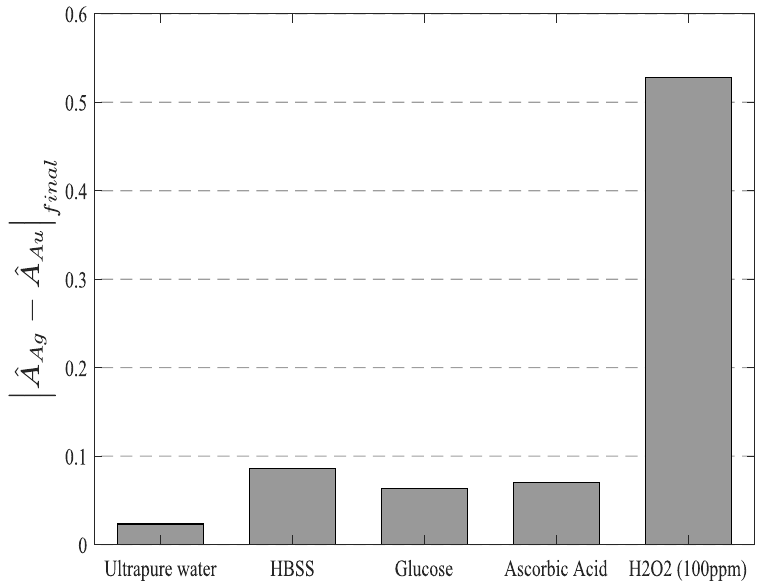
Figure 12. Cross-sensitivity of the sensors against common interferants. Hanks’ Balanced Salt Solution (HBSS), Glucose (100 mM) and Ascorbic Acid (400 ppm) were used in the cross-sensitivity test. It is shown that the response of the sensor can be considered specific to H2O2, since other reagents show readings that are more than 5 times lower, even when very high concentrations of the interfering compounds were used.